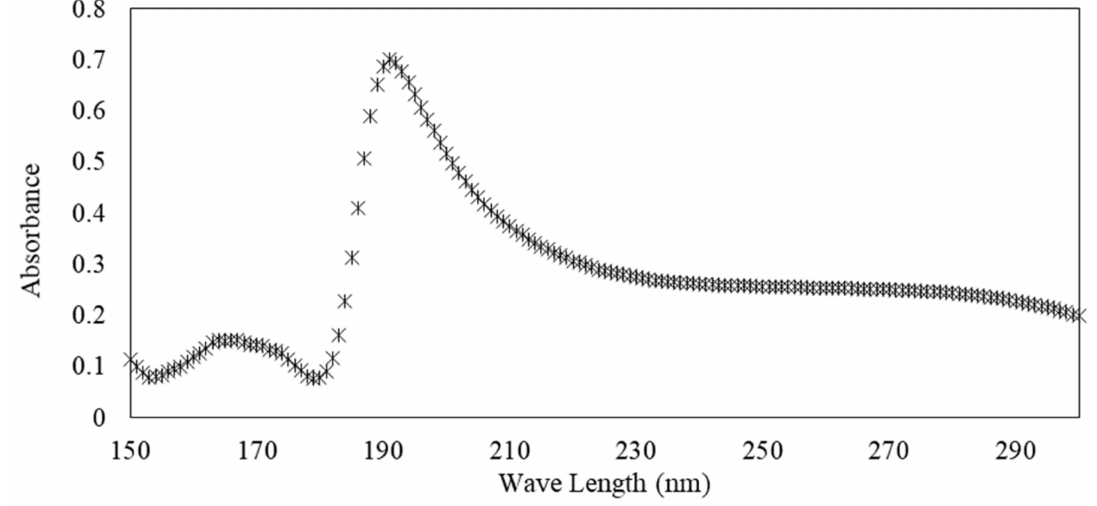
Figure 3. Illustration of the UV absorbance of solution of s/s